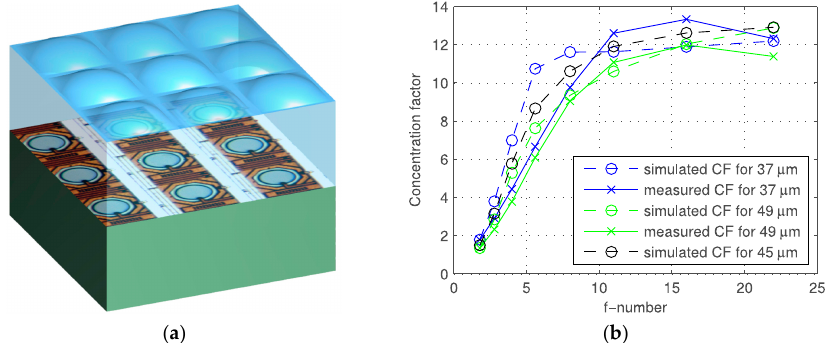
Figure 7. ( a ) Artist’s rendering of the microlens array deposited on the sensor (Courtesy: Juan Mata Pavia); ( b ) measured and simulated concentration factors as a function of the f-number in the main lens [25]. The graph shows simulated and measured data for chips with 37, 45, and 49 µm microlens height.